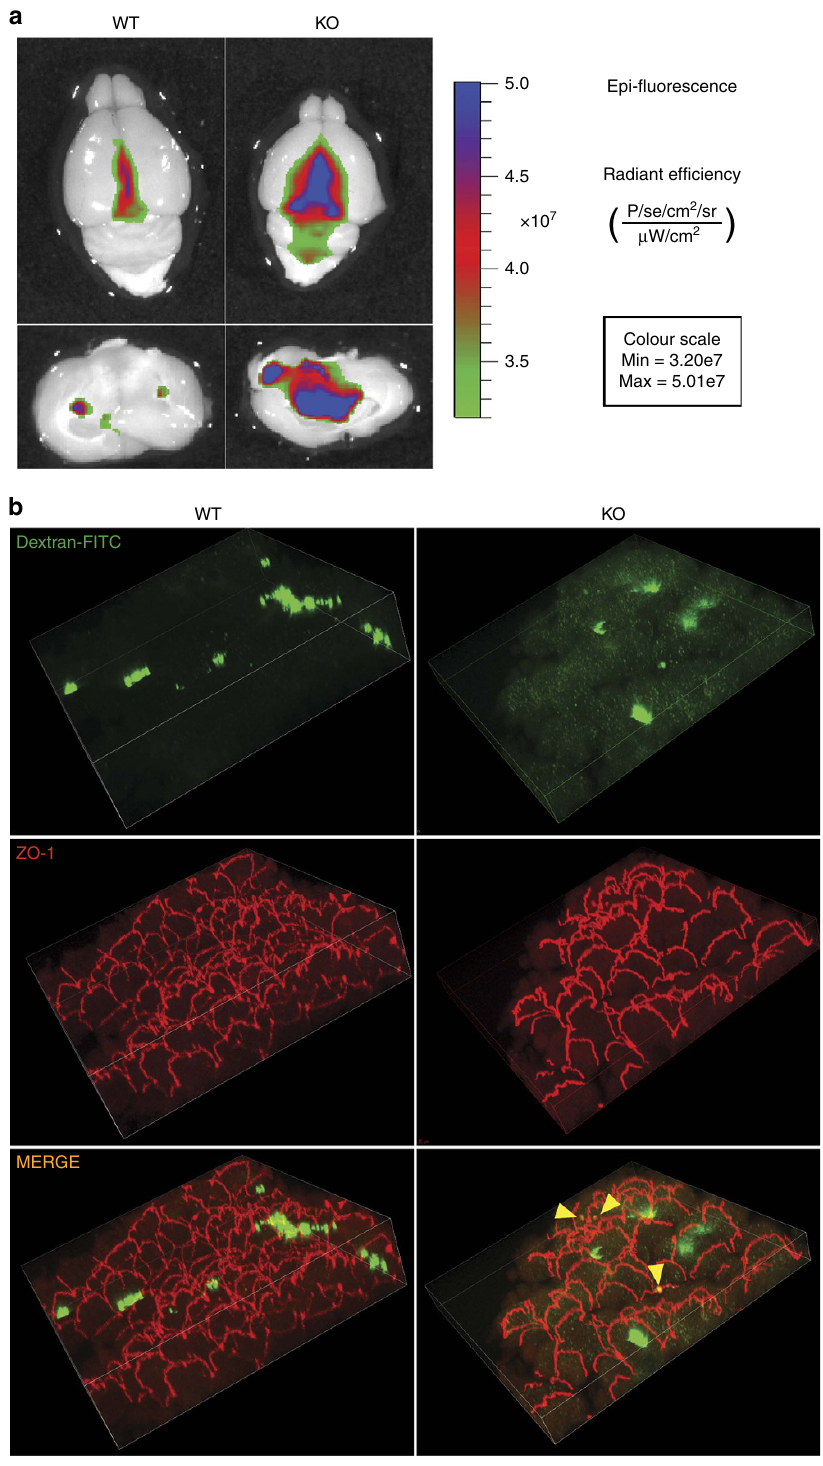
Figure 5 | Loss of Alix compromises the epithelial barrier of the CP. ( a ) Combination of brain fluorescence and bioluminescence images obtained 24h after intraperitoneal injection of the dye Evans blue ( n ¼ 3). ( b ) 3D confocal analysis of WT and Alix (cid:2) / (cid:2) whole-mount CP shows an increase intracellular flux of FITC-dextran into the Alix (cid:2) / (cid:2) CP compared with the WT; yellow arrowheads indicate points of colocalization between FITC dextran (green) and ZO-1 (red) along the basolateral membrane of the Alix (cid:2) / (cid:2) CP ( n ¼ In cells devoid of Alix, treatment with CD did not seem to further aggregates of polymerized F-actin, which also stained positive for exacerbate the F-actin depolymerization; the restoration of Alix and ZO-1 (Fig. 8a). One hour after CD removal, treated cells the actin-containing filaments and TJ remained defective during quickly re-established polymerization of the F-actin filaments; at the recovery time (Fig. 8b). The striking defects in F-actin and TJ the same time, Alix and ZO-1 were targeted to the TJ (Fig. 8a).